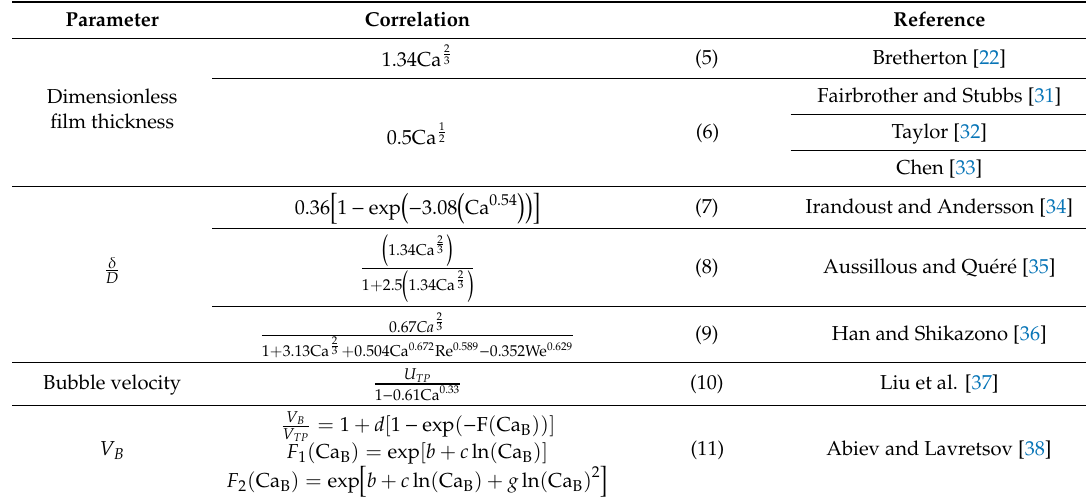
Table 1. Film thickness and velocity correlations for bubbles flowing in Newtonian